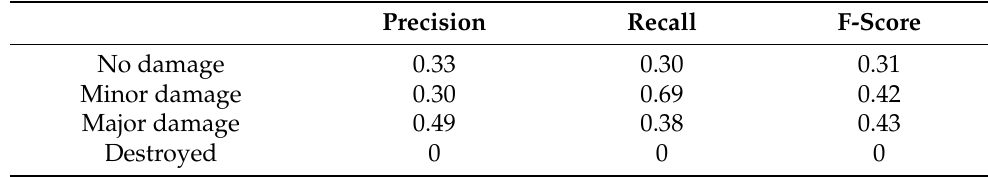
Table 6. Performance metrics for Model 1 (cost-sensitive learning strategy).